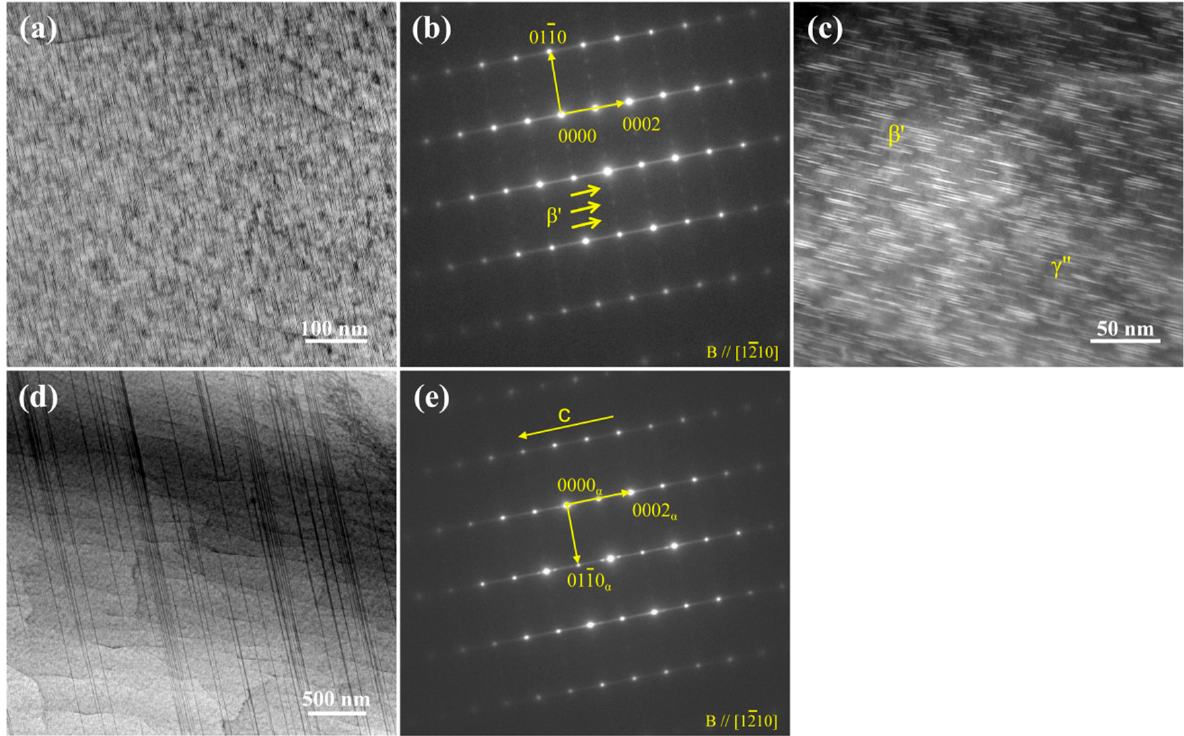
Figure 8. Microstructure of the ET6 alloy: ( a , b ) and ( d , e ) TEM images along (1-210) direction and corresponding SAED pa tt erns; ( c ) HAADF-STEM image. Notes that yellow arrows represent superstructured la tt ice.